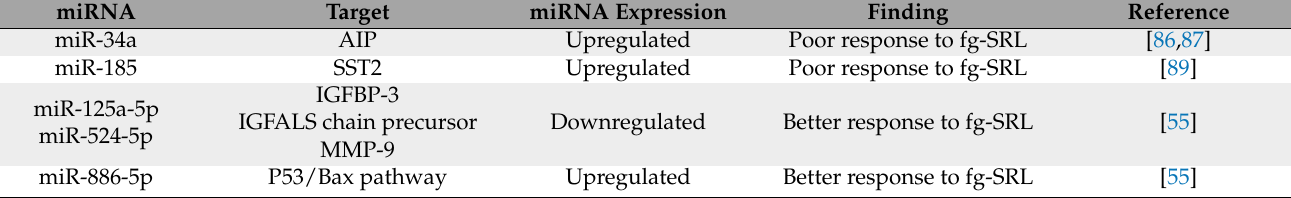
Table 2. miRNAs involved in response to fg-SRL.